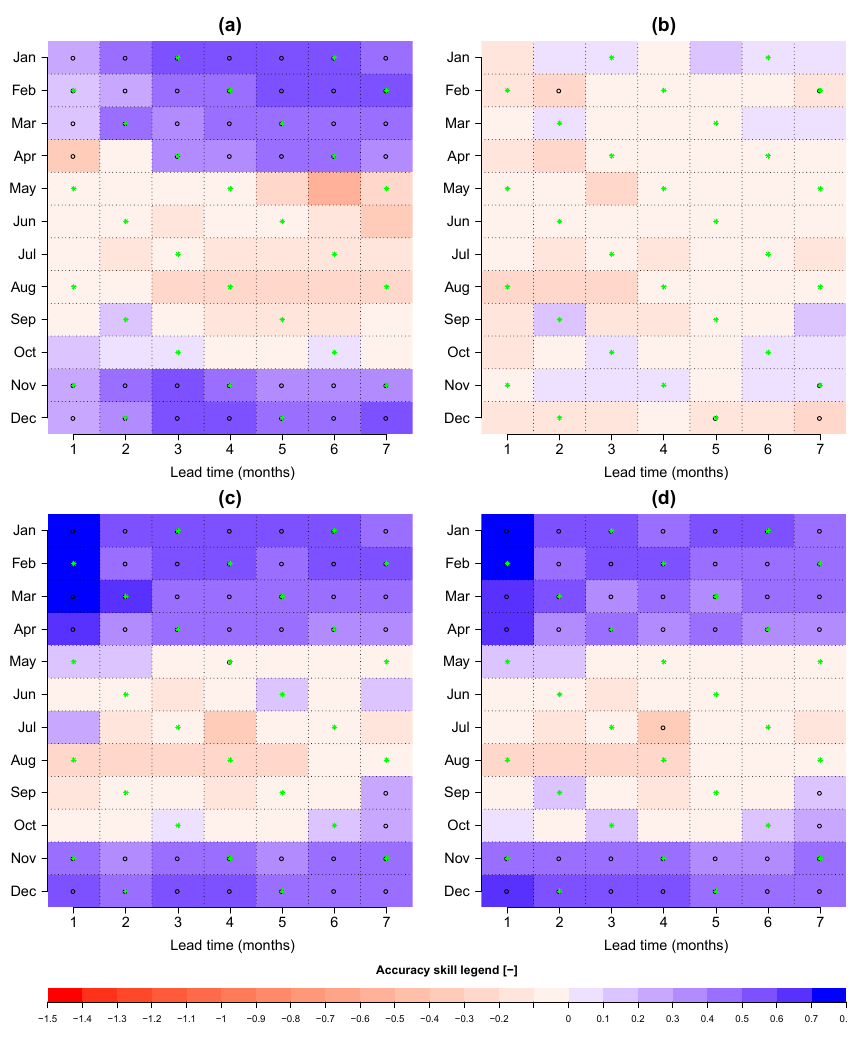
Figure 10. CRPSS of station 21 for forecasts generated using raw (a) and preprocessed (b) forcings, in addition to the post-processed streamflow forecasts using the quantile mapping method (QM) for raw meteorological (c) and preprocessed meteorological forcings using the linear scaling/delta change method (d)